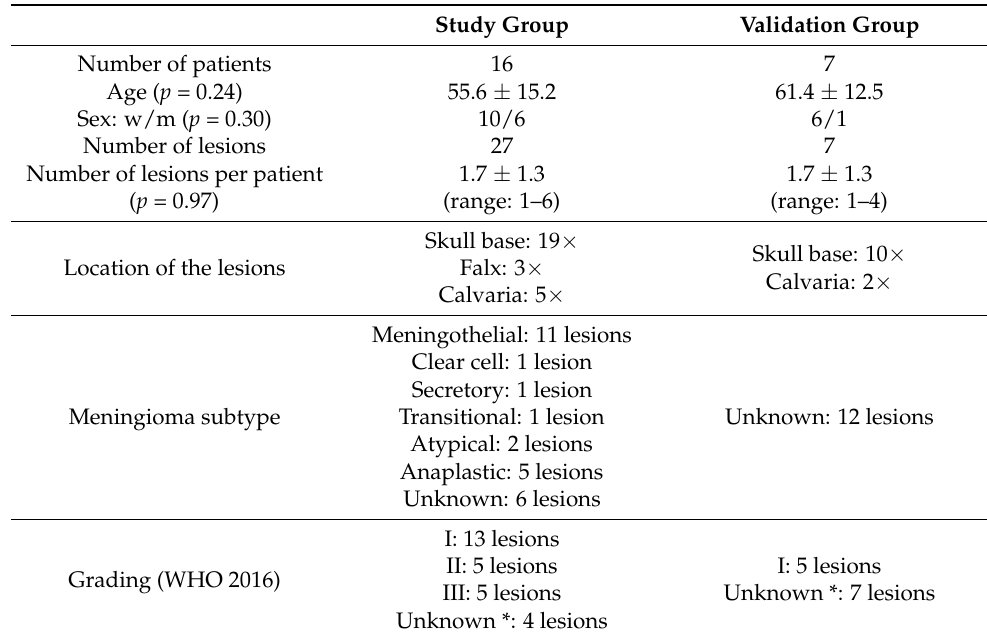
Table 1. Summary of the patient collective used in this study. * Unknown: histologies of these lesions were unknown regarding subtype and/or grading and defined as meningioma based on typical MRI and PET